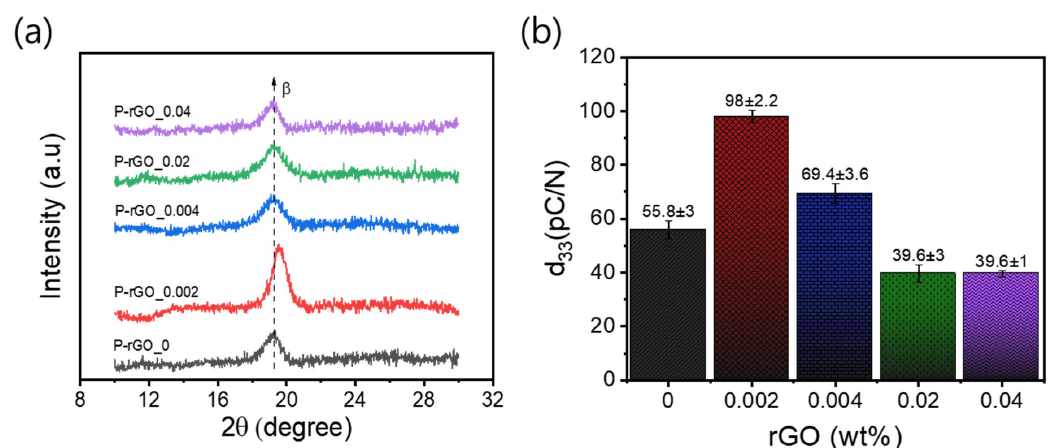
Figure 5. ( a ) XRD patterns (2 θ = 10–30°) for five thin films; ( b ) piezoelectric modulus (d 33 ) plot as a function of rGO content.